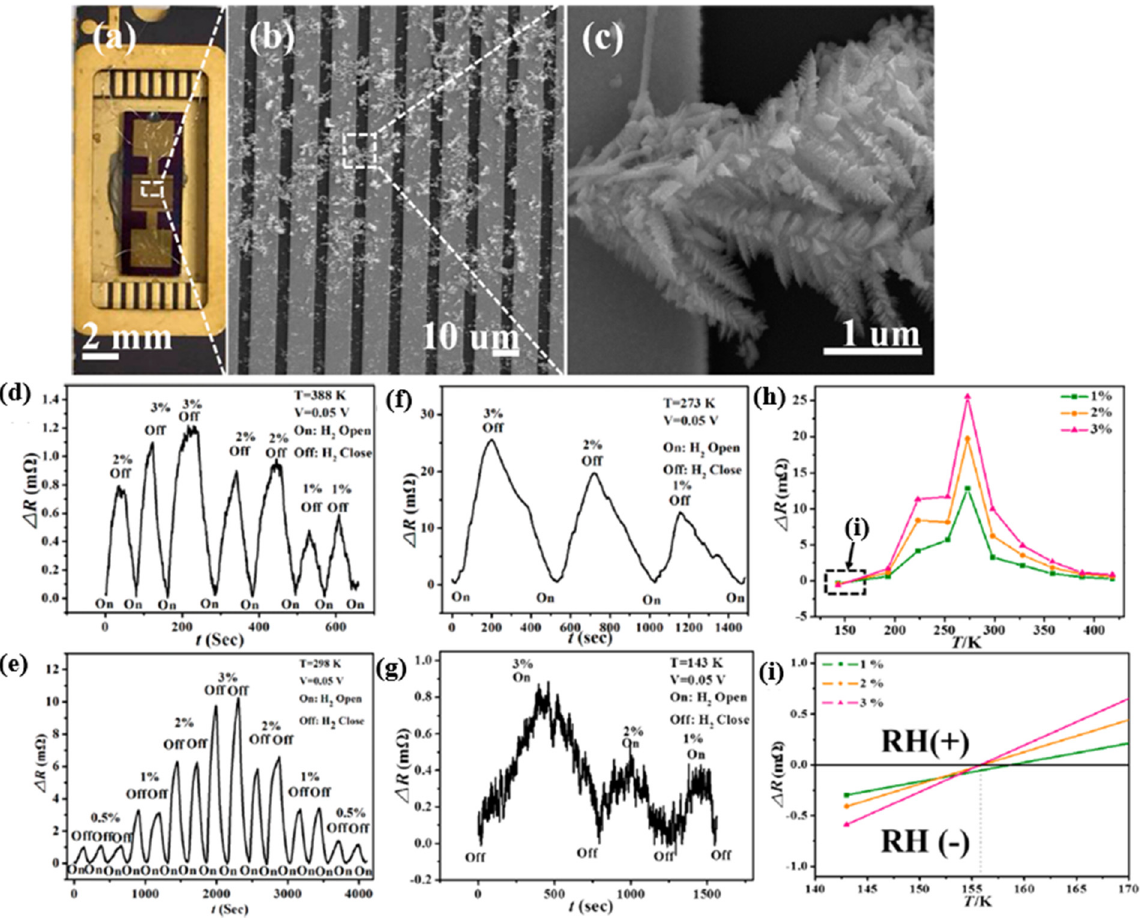
Figure 14. A hydrogen sensor of Pd/Bi/Cu hierarchical nano architectures (HNAs), SEM images and elemental mapping analysis. ( a ) The sensor prototype. ( b , c ) SEM images of Pd/Bi/Cu HNAs on IDE electrode and the magnified SEM image from the dashed rectangle in ( b ). Response of hydrogen sensor integrated with multiple HNAs. ( d – g ) ∆ R plots with the representative temperature at 388 K, 298 K, 273 K, and 143 K, respectively. ( h , i ) The summarized temperature-dependent ∆ R plots of Pd/Bi/Cu HNAs sensors. The resistance modes, negative values (below T_C), corresponds to the RH ( − ) mode and positive ones to the RH (+) mode. Here, on: introducing Hydrogen, off: venting hydrogen, ∆ R: alteration of resistance [79]. Copyright (2019), with permission from American Chemical